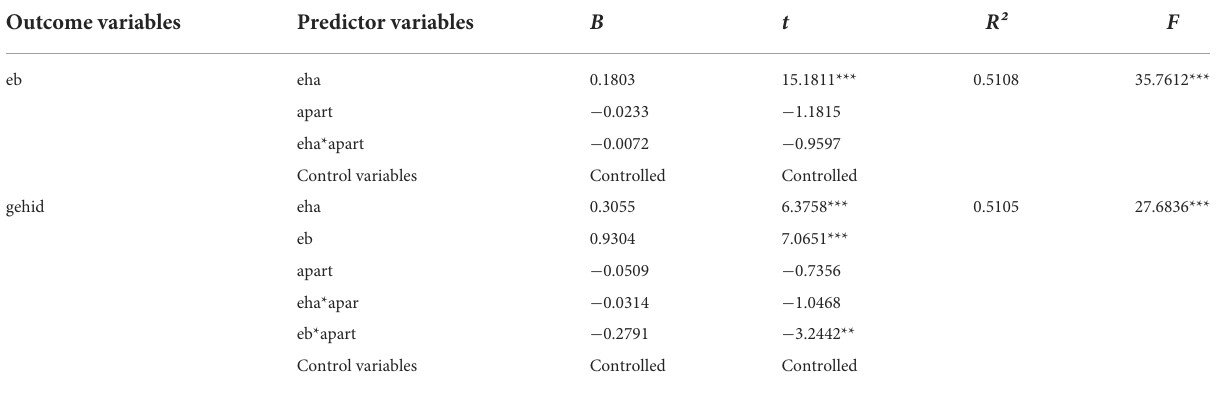
TABLE 10 Moderated mediation results. Outcome